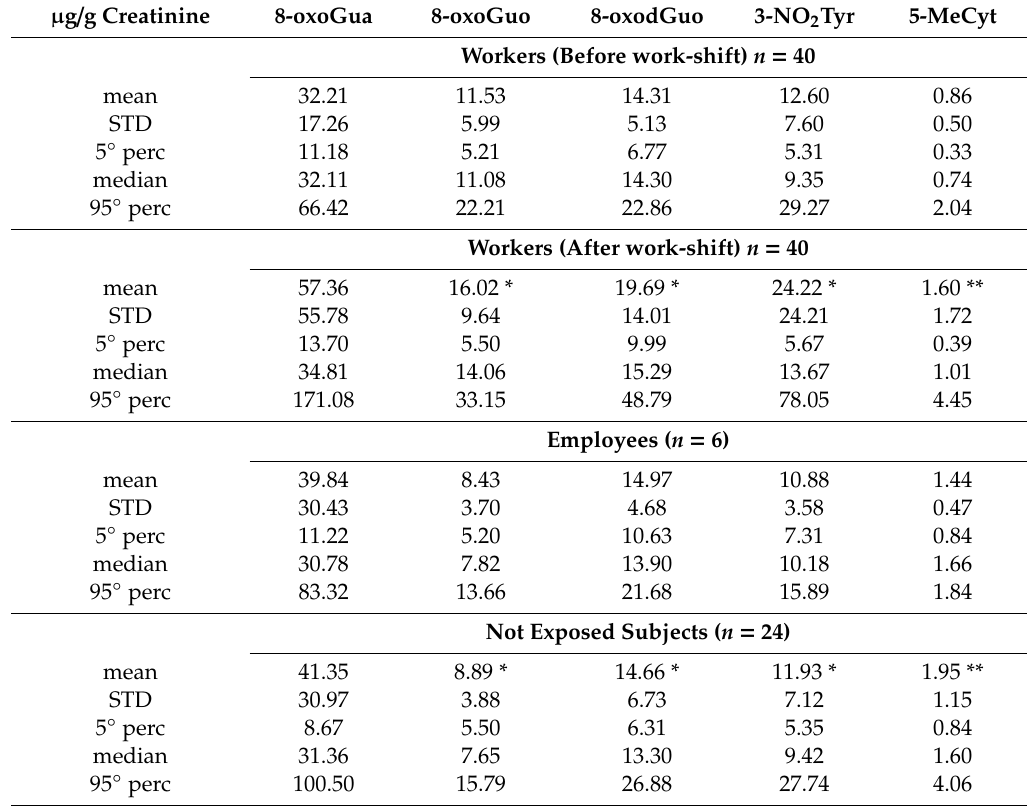
Table 3. Urinary concentrations of biomarkers of nucleic acid oxidation and nitro-oxidation in workers, before and after the working shift, and in not-exposed subjects (employees and volunteers). µ g / g Creatinine